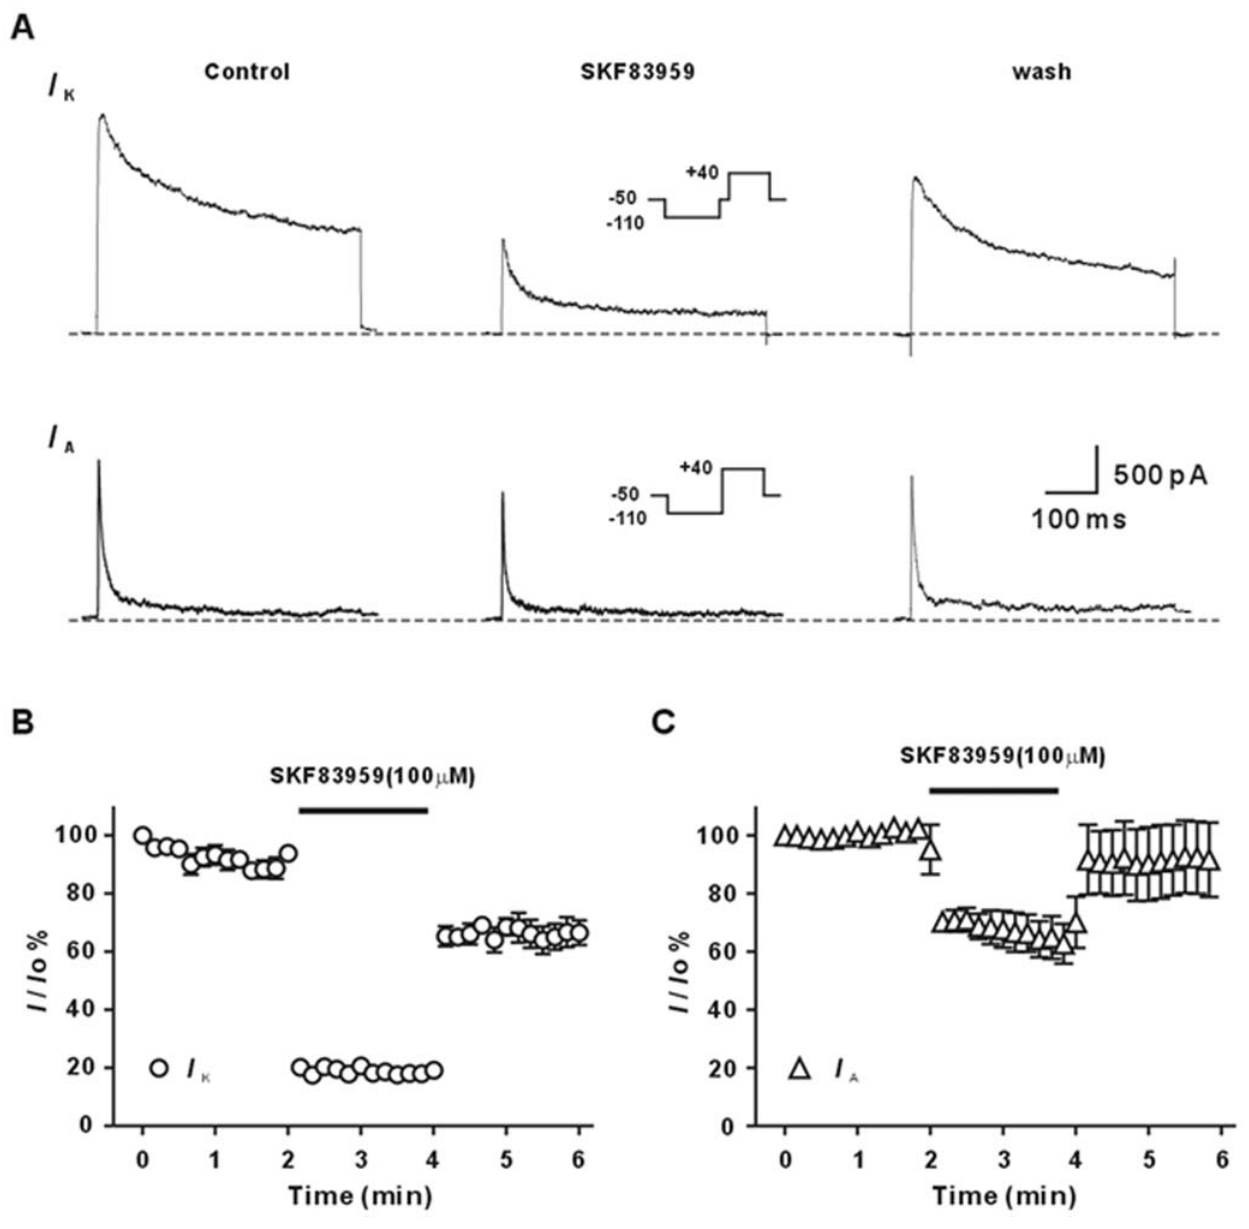
Figure 2. Inhibition of voltage-activated K + currents by ( 6 ) SKF83959 in rat hippocampal neurons. (A) Upper and lower are the respective representative traces of the delayed rectifier K + current ( I K ) and fast transient K + current ( I A ) recorded prior to and during superfusion with ( 6 ) SKF83959 (100 m M) and after 10 s of washout. The neuron was held at 2 50 mV. Upper inset shows the pulse protocol to elicit I K , whereas lower inset shows the protocol to elicit the total K + current. I A is the subtraction of I K from the total K + current. (B) and (C) Time courses of the inhibition of I K and I A by ( 6 ) SKF83959 (100 m M, n=5 for each). The bar denotes the surpufusion with SKF83959. A number of symbols in (B) and (C) have error bars smaller than their